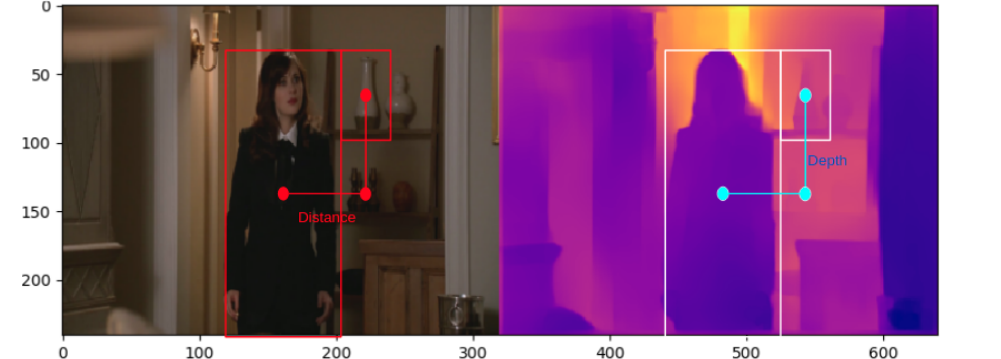
Figure 10. Comparison of frame 26070 with its estimated depth. Using the depth and distance measures, the actual distance between the two objects can be